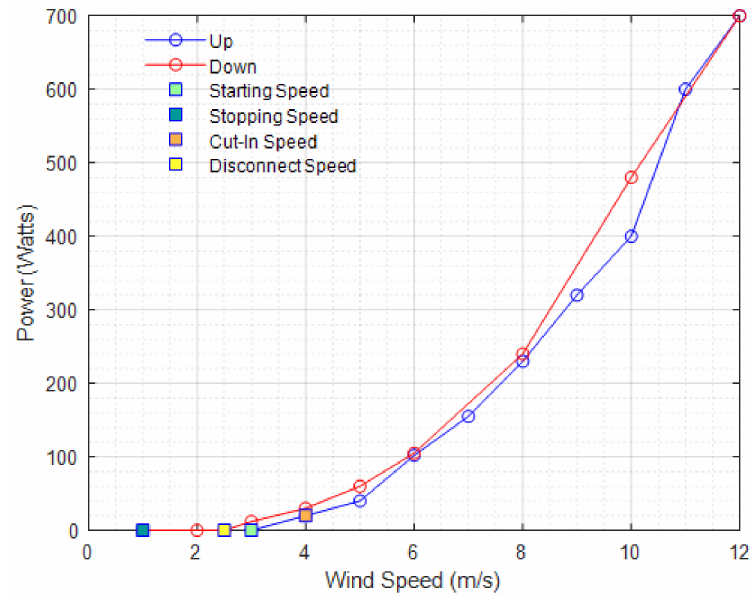
Figure 20. Experiment where rotor alignment with the flow is assessed from a complete stop and a 90 ◦ misalignment and by increasing the wind speed until the rotor becomes fully aligned at 0 ◦